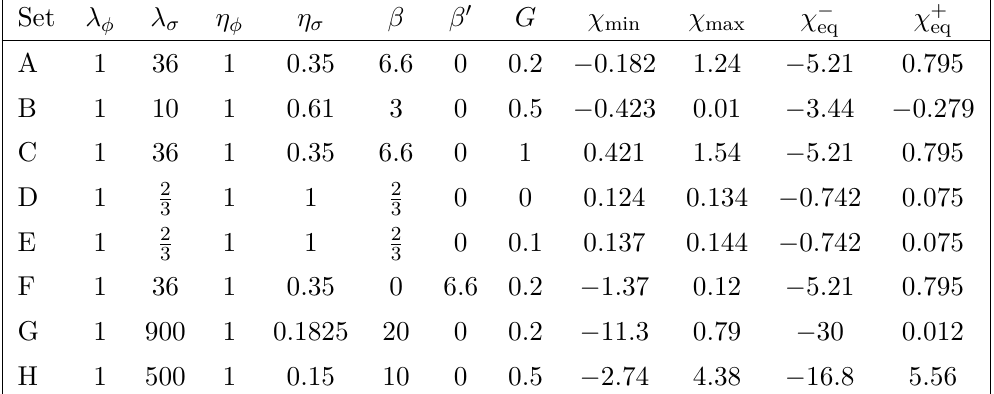
Table 1 . The sets of parameters used in this paper. The range of χ for which localised supercon- ducting strings exist and the range for which the vacuum state is the global minima of the effective potential are also listed. Set D has been studied in [20] (and set E is the gauged extension of this), while set F is the gauged extension of a parameter set that was studied in [18] (with A and C being related parameter